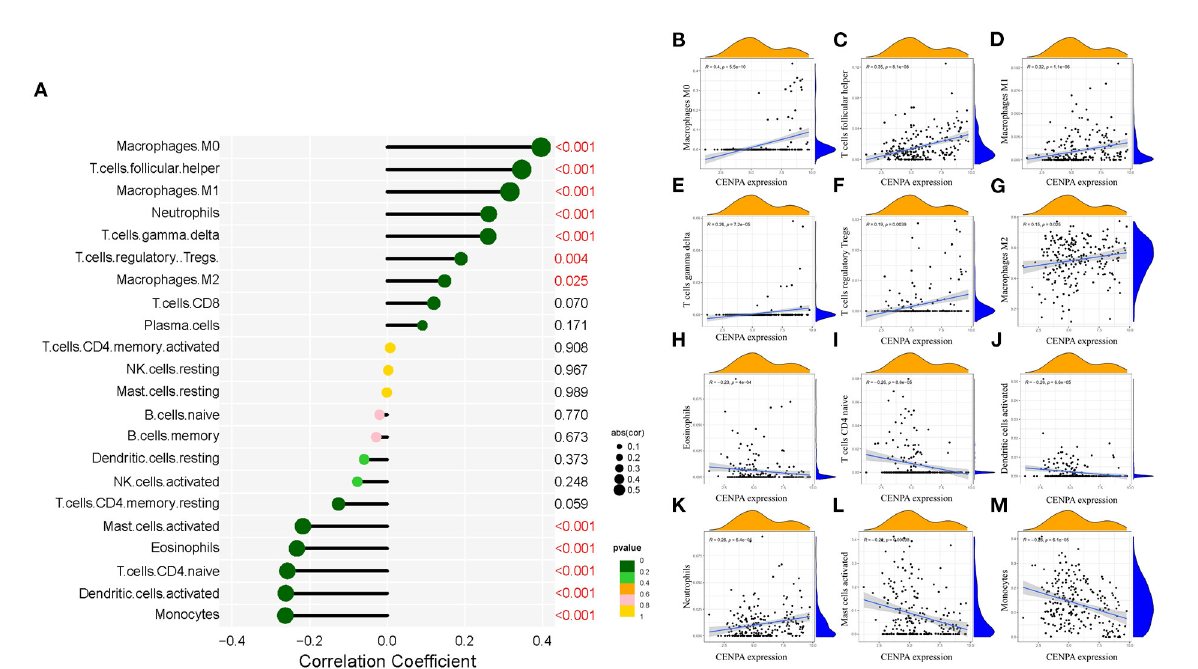
FIGURE7 Correlation between CENPA expression and immune cell filtration in the CGGA database and TCGA database. (A) Correlation between CENPA expression and 22 kinds of immune infiltration cells in TCGA database. (B–M) Scatter plots of correlation between CENPA and significantly related immune-infiltrating cells ( p < 0.05). Pearson coefficient was used for the correlation